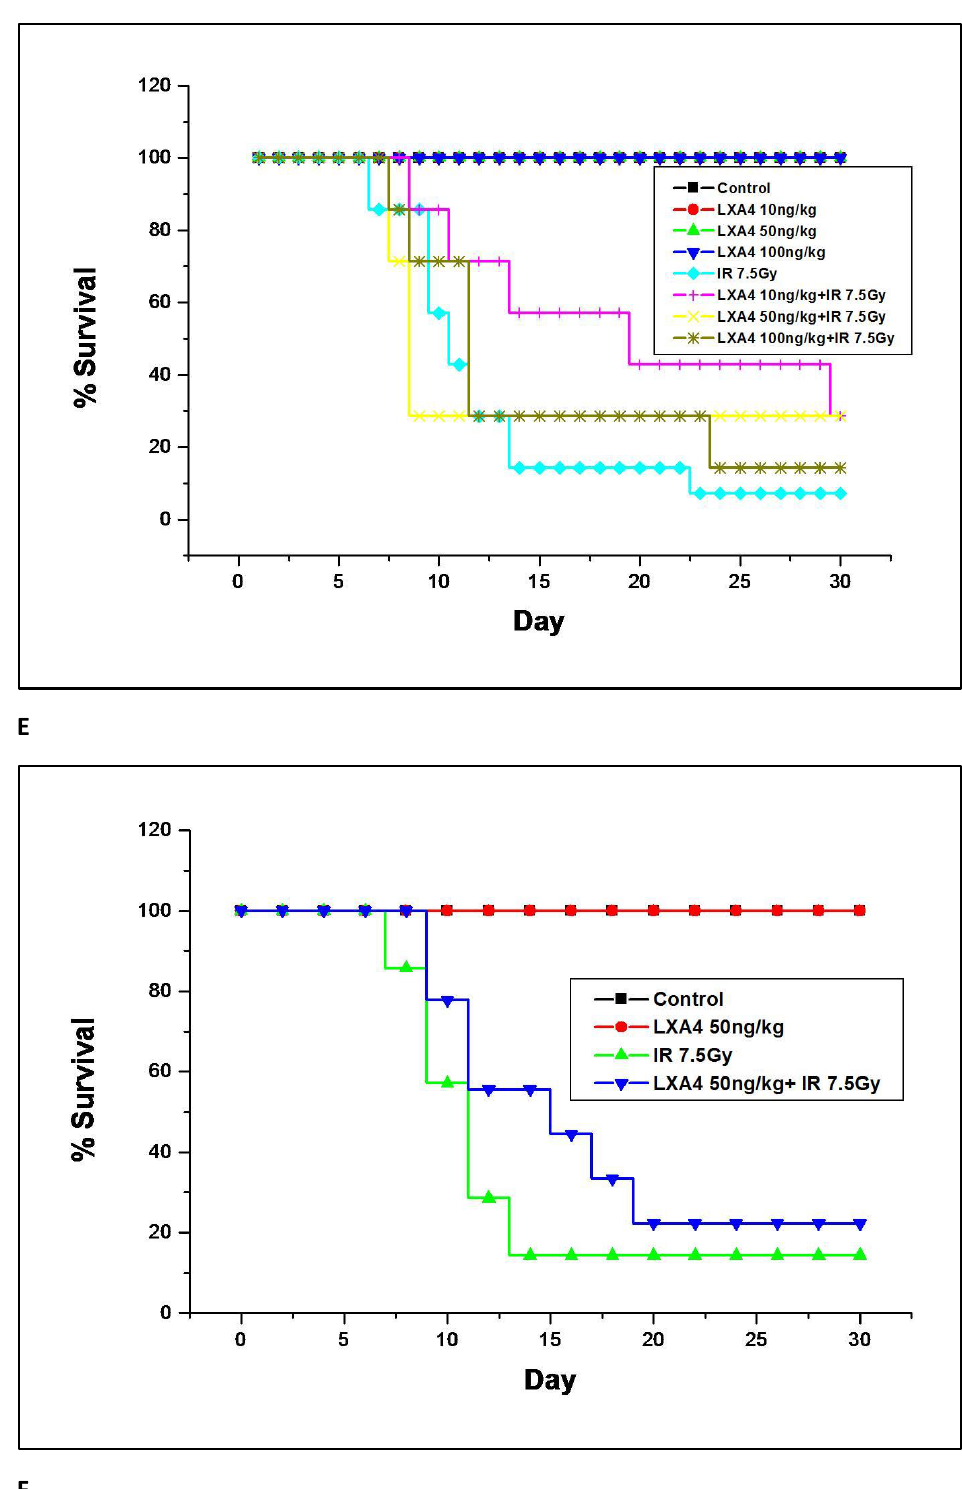
Figure 10. Effect of various PUFAS and LXA4 on radiation-induced mortality in female mice. Mice were pre-treated with GLA (10, 50, and 100 µ g/kg) at 48, 24, and 1 h prior to irradiation and were subjected to total-body irradiation of 7.5 Gy (at 1 Gy/min). Values (n = 12) expressed as %Survival ( A ) and variation in body weight ( B ). Mice were pre-treated with 100 µ g/kg PUFA (DGLA, AA,